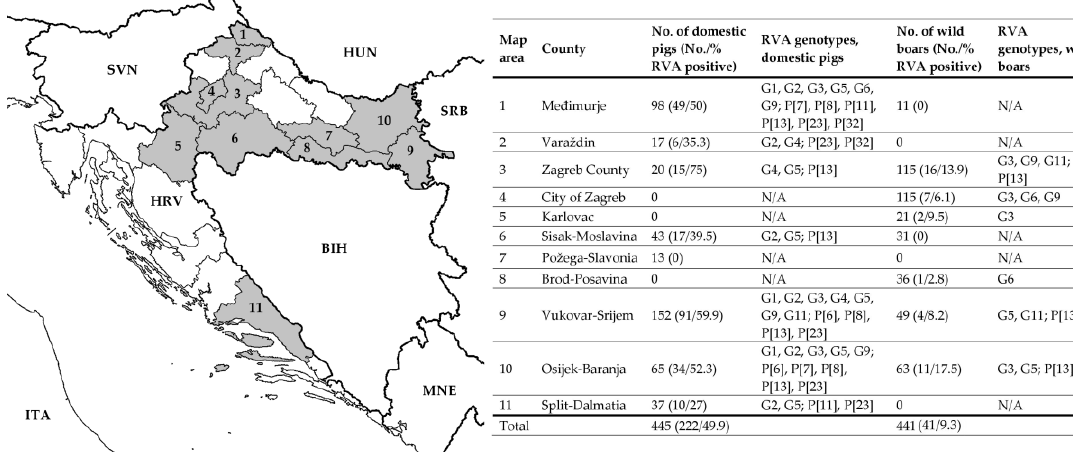
Figure 1. Geographical distribution of sampling sites and the results of RVA detection and genotyping (VP7 and VP4) in domestic pigs and wild boars. Counties included in the present study are marked in grey. N/A stands for Not Applicable in the case there were no samples taken or all collected samples were negative on RVA. The map source is available at: https://commons.wikimedia.org/wiki/File: Croatia_location_map.svg (NordNordWest; CC BY-SA 3.0; accessed on 11 January